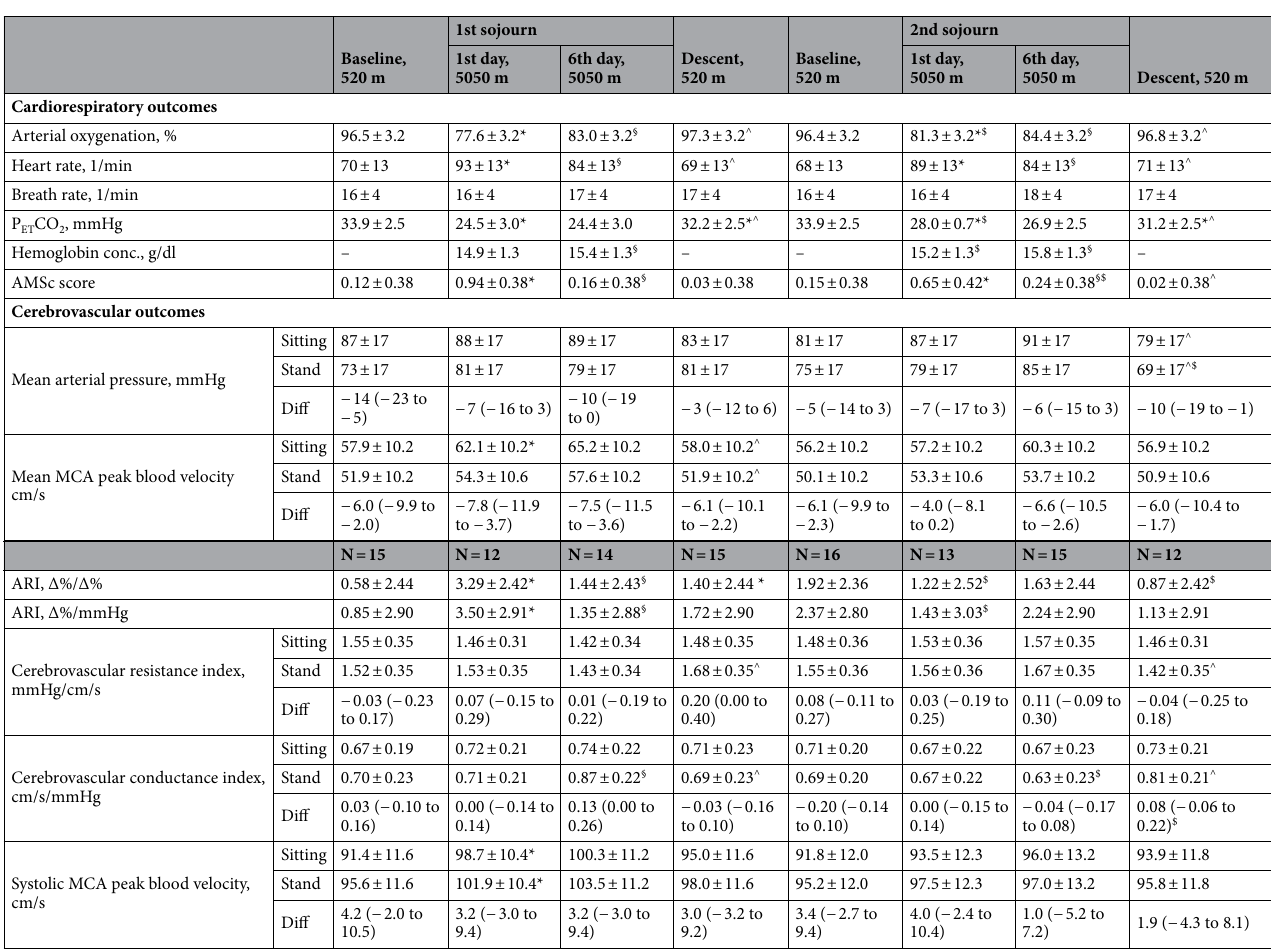
Table 2. Cardiorespiratory and cerebrovascular outcomes. Data are presented as mean ± SD or mean difference (95% CI). To avoid unnecessary multiple testing and false positive results, comparisons between day 6 at 5050 m vs. baseline (both, during the 1st and 2nd sojourn), descent vs. day 1 at 5050 m (both, during the 1st and 2nd sojourn) and baseline during the 2nd vs 1st sojourn were not statistically compared. P ET CO 2 , end- tidal partial pressure of CO 2 ; AMSc score, environmental symptom questionnaire cerebral score; MCA, middle cerebral artery; MAP, mean arterial pressure; ARI, autoregulation index. * P < 0.05 versus 520 m baseline within sojourn; § P < 0.05 between 6th versus 1st day at 5050 m; $ P < 0.05 when comparing 2nd versus 1st sojourn effects from acute (1st day 5050 m—520 m), prolonged (6th versus 1st day at 5050 m) or recovery (Descent 520 m—6st day at 5050 m); ^ P < 0.05 between descent 520 m versus 6st day at 5050